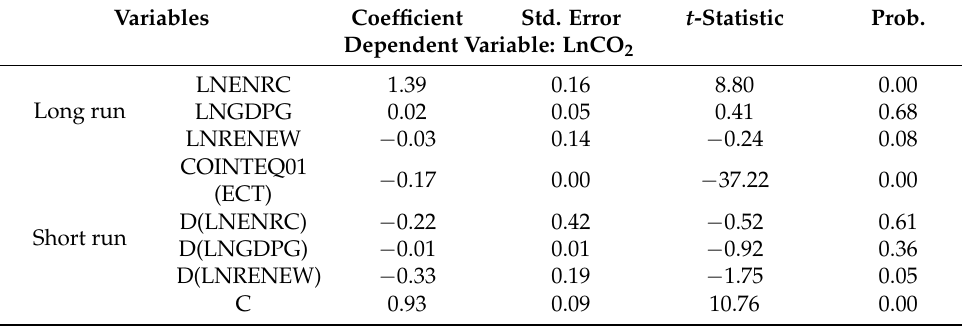
Table 7. Long-Term and Short-Term Dynamics through PMG Panel ARDL.